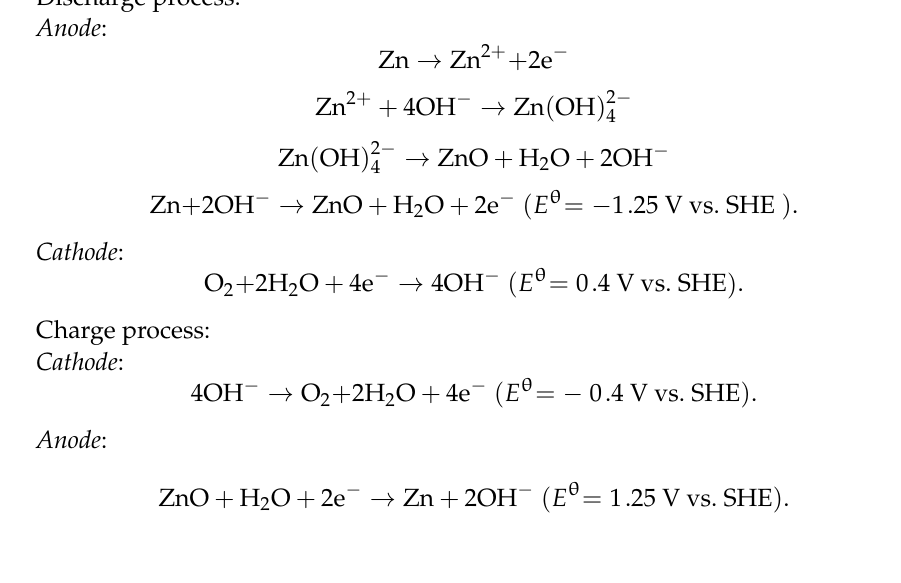
Figure 2. Schematic illustration of the reaction mechanism of a rechargeable Zn–air battery [47]. Reprinted with permission from Ref. [47]. Copyright © 2022 Elsevier Ltd.